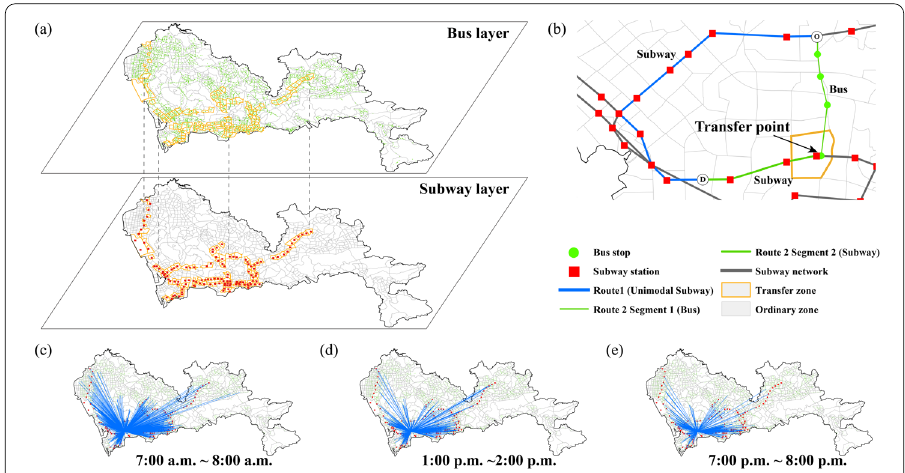
Figure 1 Illustration of a multiplex transportation network. ( a ) Multiplex public transportation network of Shenzhen. Bus stops (light green dots), subway stations (red squares), transfer zones (orange polygons), ordinary zones (grey polygons), and four inter-links (dashed lines) between the two network layers are illustrated. ( b ) Path depicted in blue represents a unimodal subway trip. Path depicted in green represents a multimode trip using both bus and subway transportation. ( c )–( e ) SDNs of one destination zone during 7:00 a.m.–8:00 a.m., 1:00 p.m.–2:00 p.m., and 7:00 p.m.–8:00